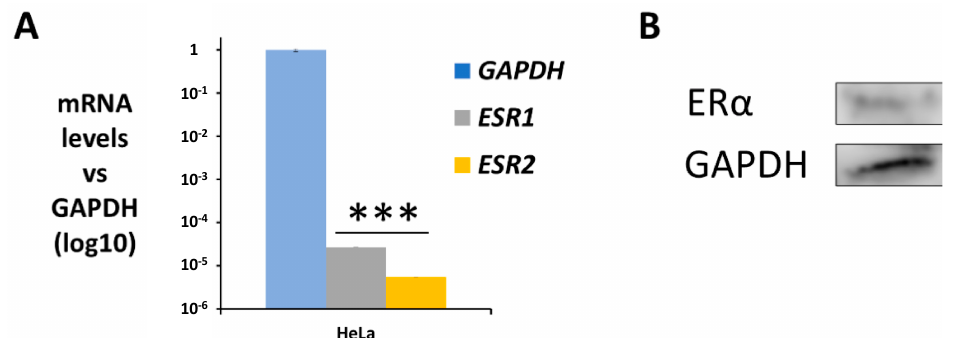
Figure 1. ER expression in HeLa cells. ( A ) Gene expression profile of both ER isoforms using qPCR, graphed relative to the housekeeping GAPDH as mean ± SEM ( n = 3). ( B ) Western Blot of ER α expression using GAPDH as housekeeping ( *** p < 0.001).